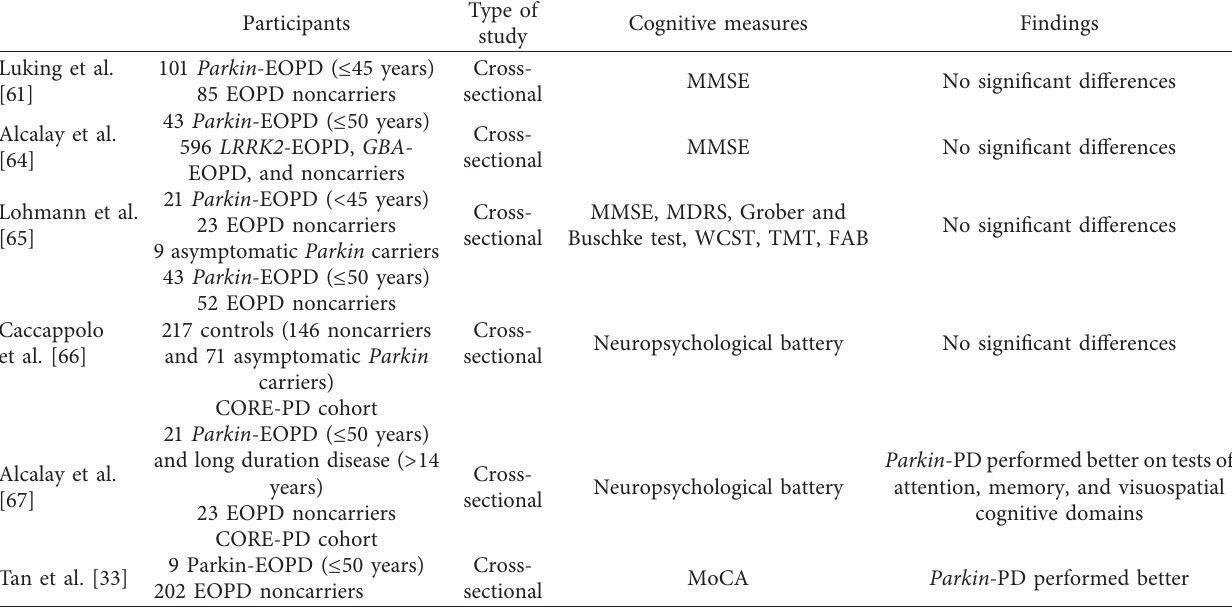
Table 2: Studies assessing cognitive function in Parkin -associated